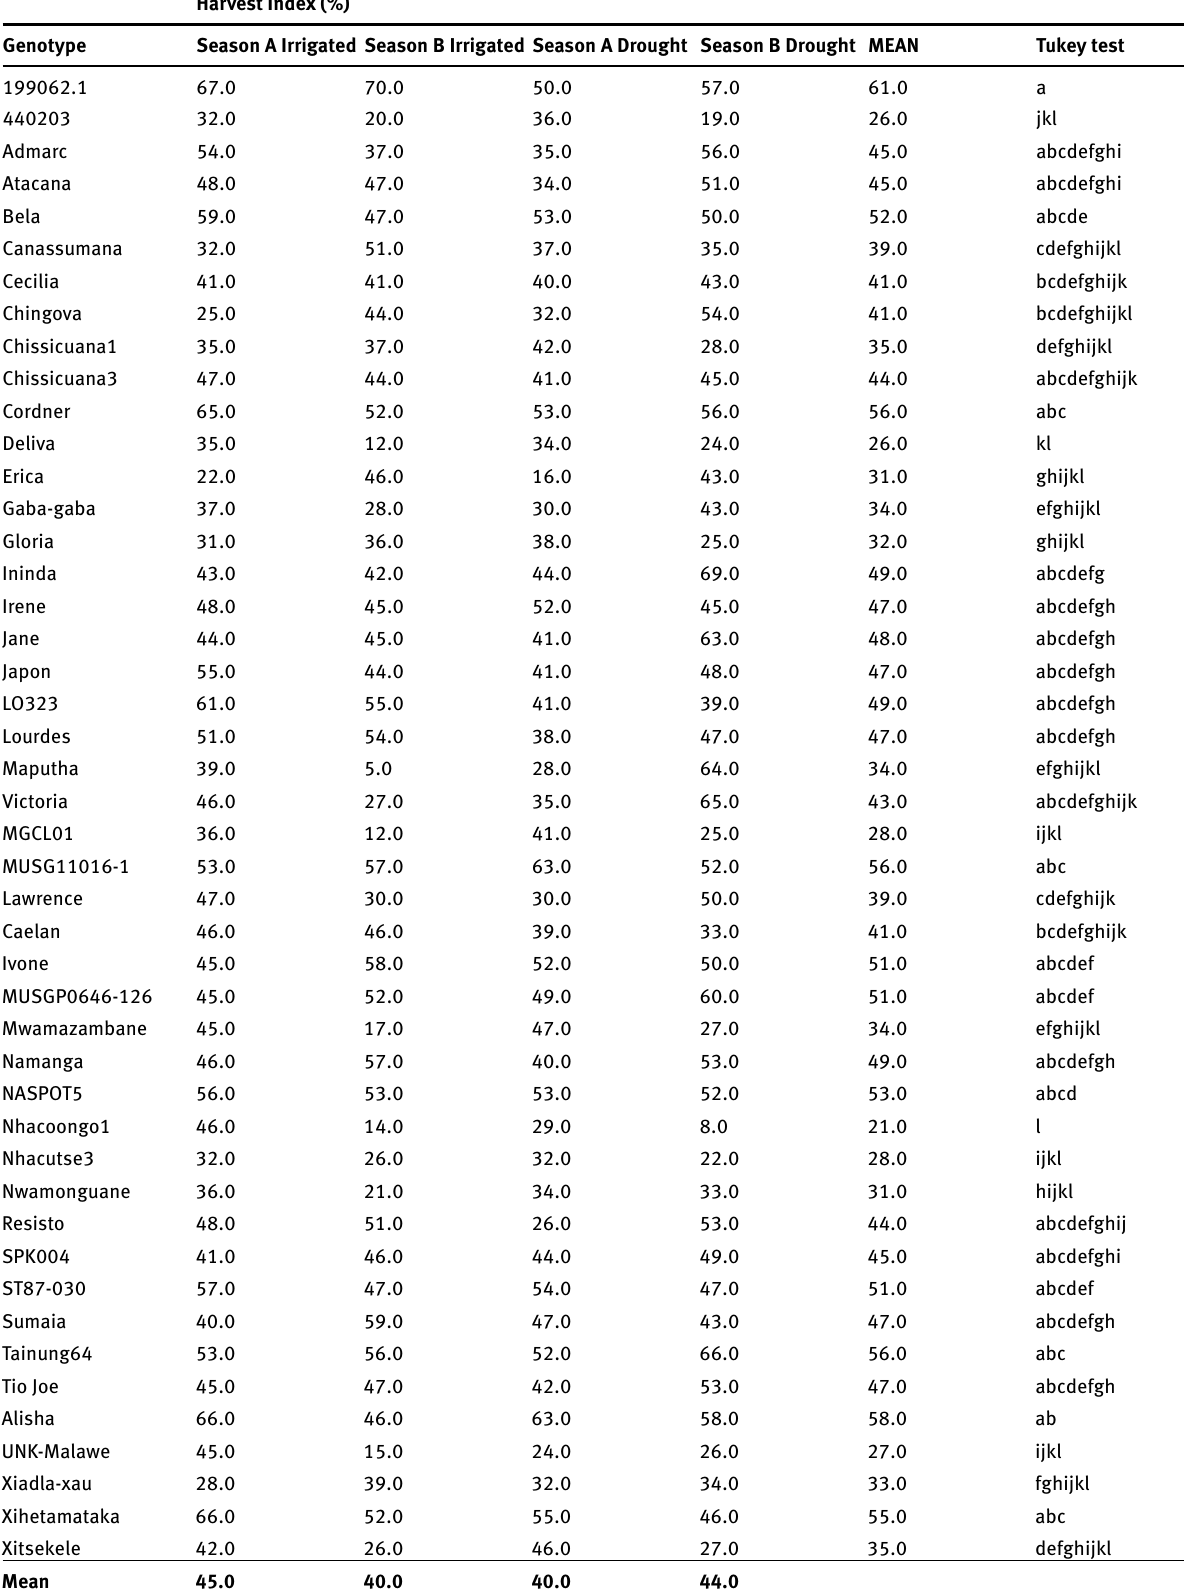
Table 3: Harvest Index for genotypes under well-watered (irrigated) and water deficit (drought) treatments at Umbeluzi Research Station, 2015 Harvest Index